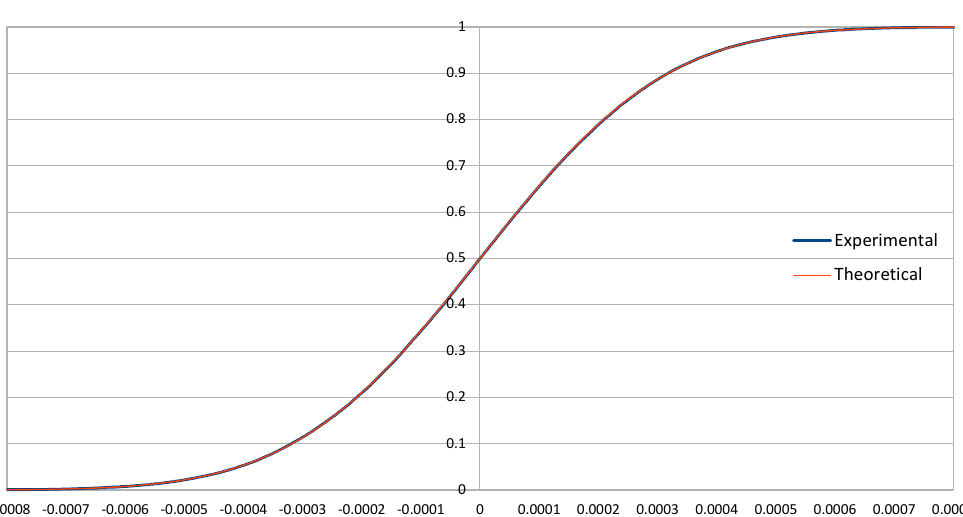
Figure 14: Experimental and theoretical cumulative distributions for C( a, b ), with ( a, b ) = ( 0x0008c0 , 0x1a0974 ) using 40 × 2 12 randomly chosen key samples. The experimental line contains the cumulative ratio of the keys for which the linear approximation ( a, b ) has value of x and the theoretical line the expected cumulative ratio of keys in the case of a Normal distribution with µ = 0 and σ 2 = ELP = 1 . 034764 × 2 − 24